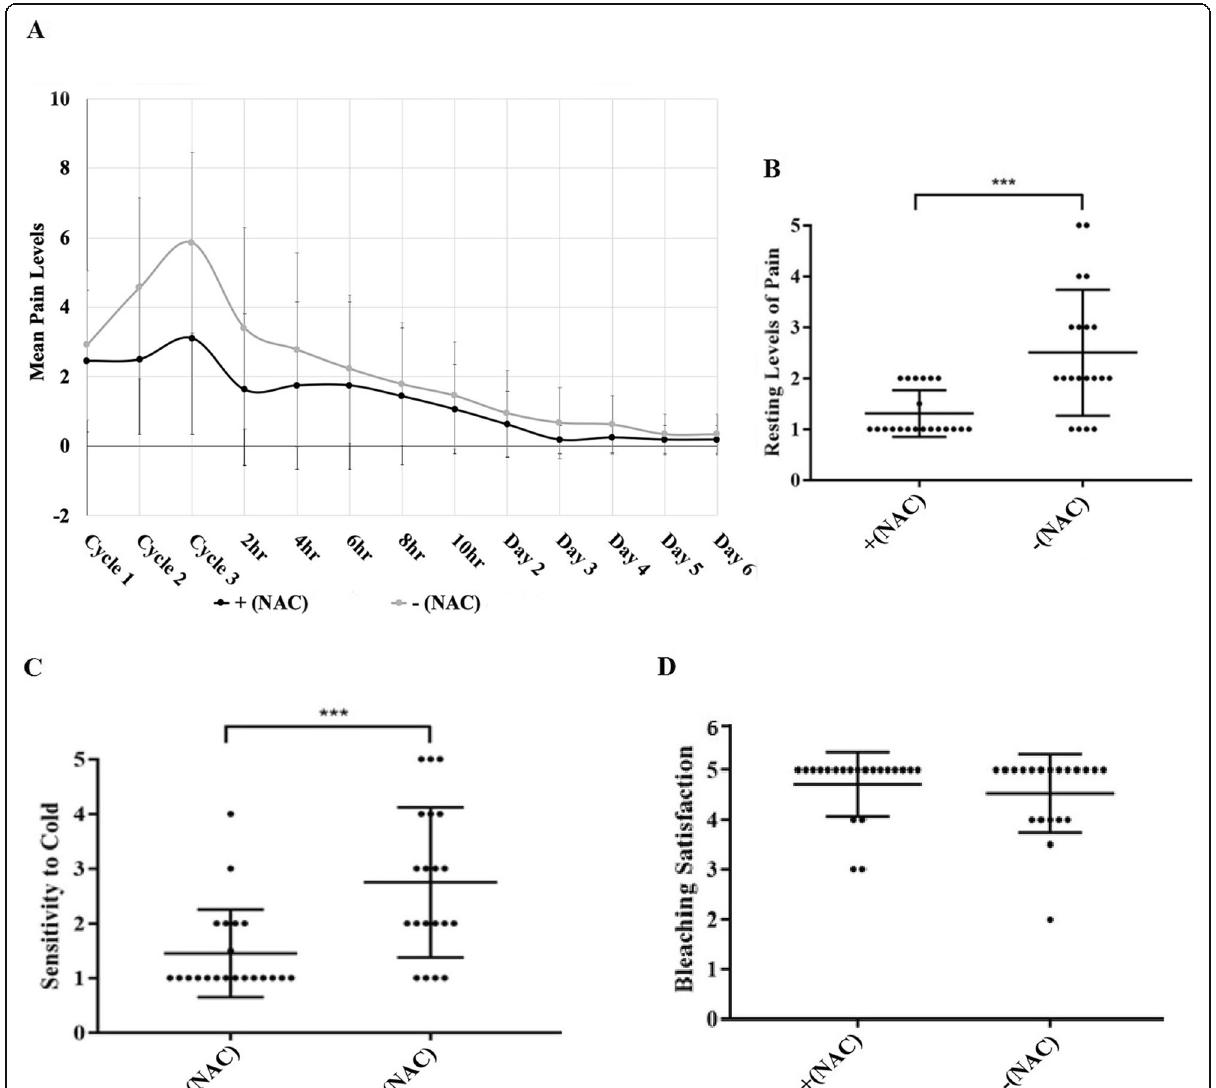
Fig. 5 NAC-treated group experienced lower levels of pain, decreased sensitivity to cold and similar degrees of satisfaction of the bleaching outcome based on their exit interview responses. The levels of pain measured at a scale of 0 – 10, 10 being the most painful, in patients were collected after each of the three bleaching cycles and every 2 hours post-procedure for the first 10 h, and thereafter on a daily basis for 5 days. The mean values for each time point was plotted for both H2O and NAC-treated patients. A Wilcoxon Rank Sum Test (Mann-Whitney U Test) was performed for each time point to compare significant differences in patient responses. Higher pain levels were noted in H2O group with significant differences in cycle 2 ( p = 0.012), cycle 3 ( p = 0.005), and 2-h post-treatment ( p = 0.048) ( a ) Exit interview response for overall levels of pain experienced by patients were recorded on a scale of 0 – 5 with 5 being the most painful, and plotted for both H2O and NAC groups. A Wilcoxon Rank Sum Test (Mann-Whitney U Test) was used to calculate statistical significance. Patients receiving bleaching and NAC experienced a lower resting pain level with a P -value of 0.0002 ( n = 21) ( b ). Exit interview response was obtained for overall experience to sensitivity to cold on a scale of 0 – 5, with 5 being the most sensitivity to cold stimulus. A two-tailed, unpaired t-test showed a significantly higher sensitivity to cold in control patients, with a P-value of 0.0006 ( n = 20) ( c ). Exit interview response was obtained for post-procedure satisfaction of bleach whitening esthetics according to a 0 – 5 scale, with 5 being the most satisfied. A two-tailed t-test showed that NAC patients were equally satisfied with their bleaching cosmetic outcome, with a P = value of 0.35 ( n = 21) ( d